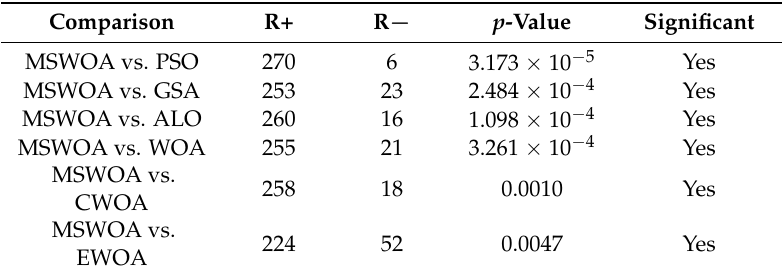
Table 8. The Wilcoxon signed-rank multiple-problem test for statistically significance level at alfa = 0.05. Comparison